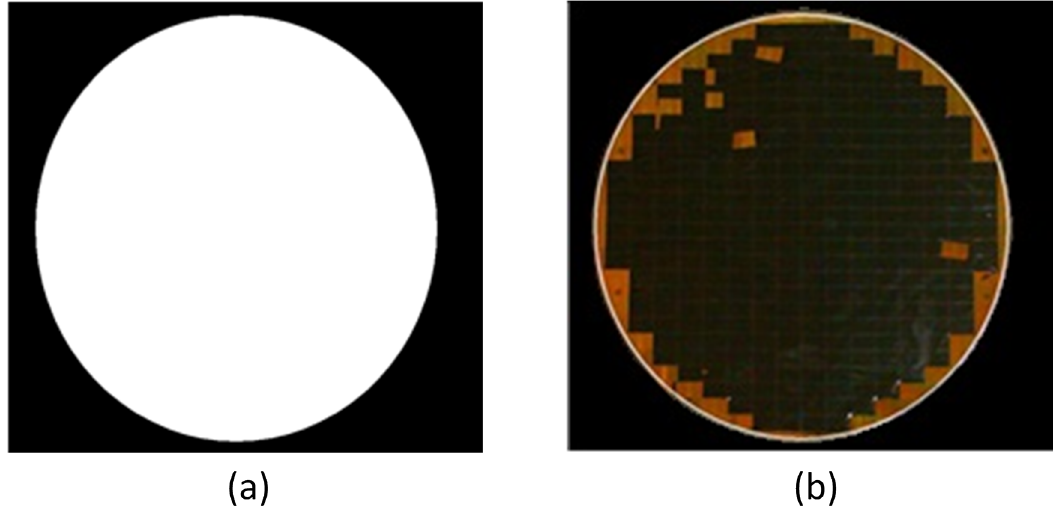
Figure 8. ( a ) The mask of the wafer image; ( b ) the wafer image in which the region outside the white contour has been